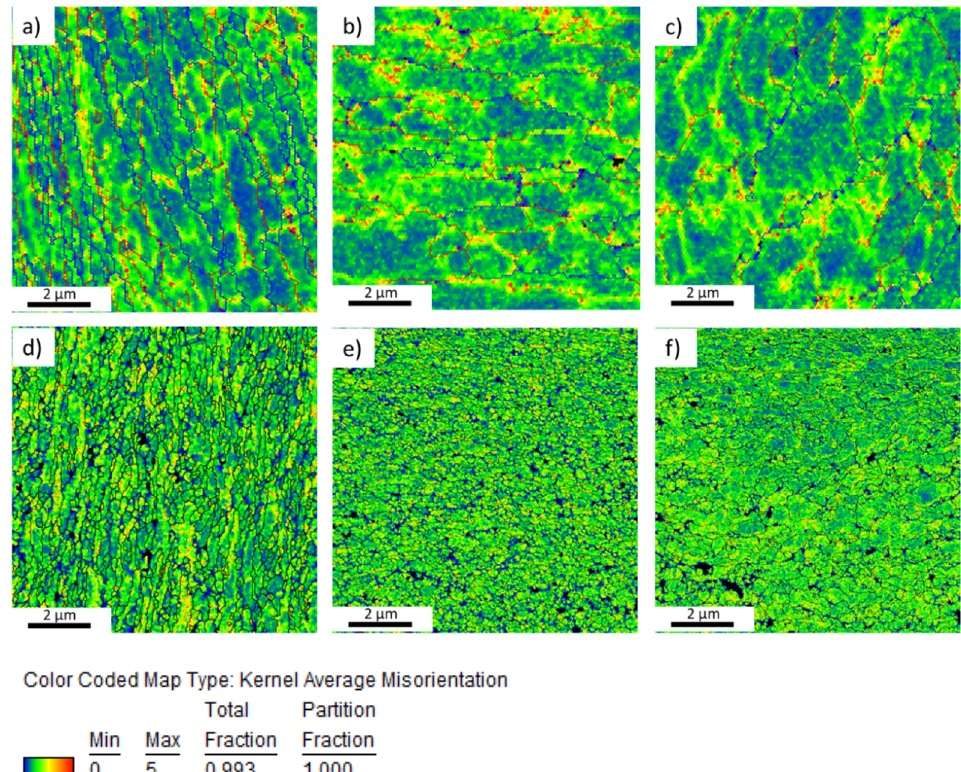
Figure 6. KAM maps evaluated from the OIMs corresponding to the tube processed with stationary mandrel ( a – c ) and to the tube processed with rotating mandrel ( d – f ).